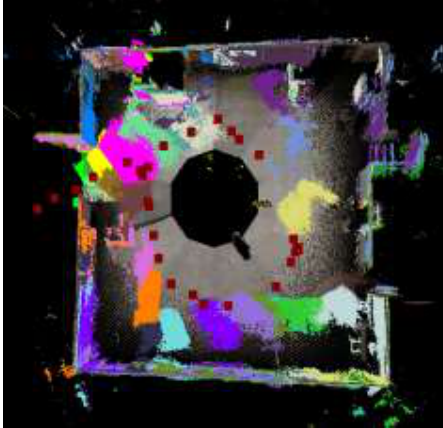
Figure6. Tracing points of fused data thinning